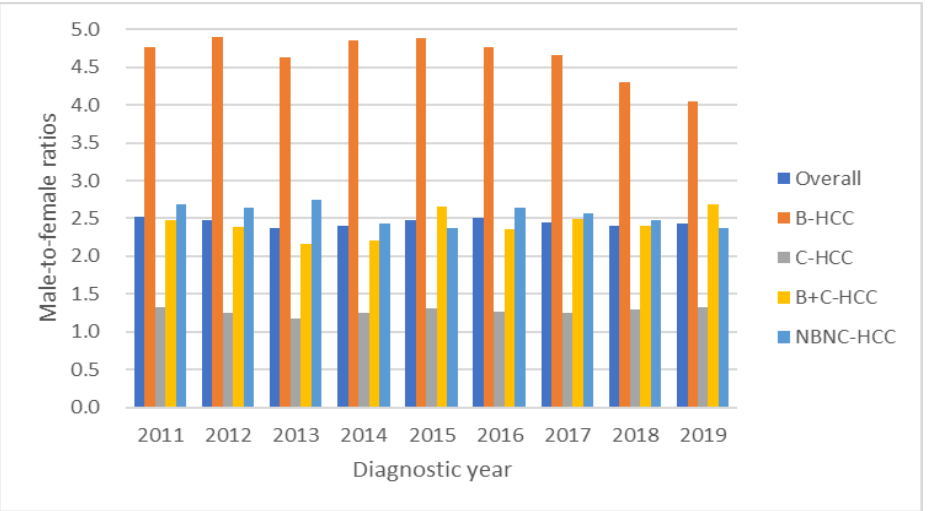
Figure 5. The male-to-female ratios of overall, B-HCC, C-HCC, B+C-HCC and NBNC-HCC were 2.4, 4.6, 1.3, 2.4 and 2.5, respectively. The B-HCC showed decreasing trend from 4.8 to 4.1 during the study period.